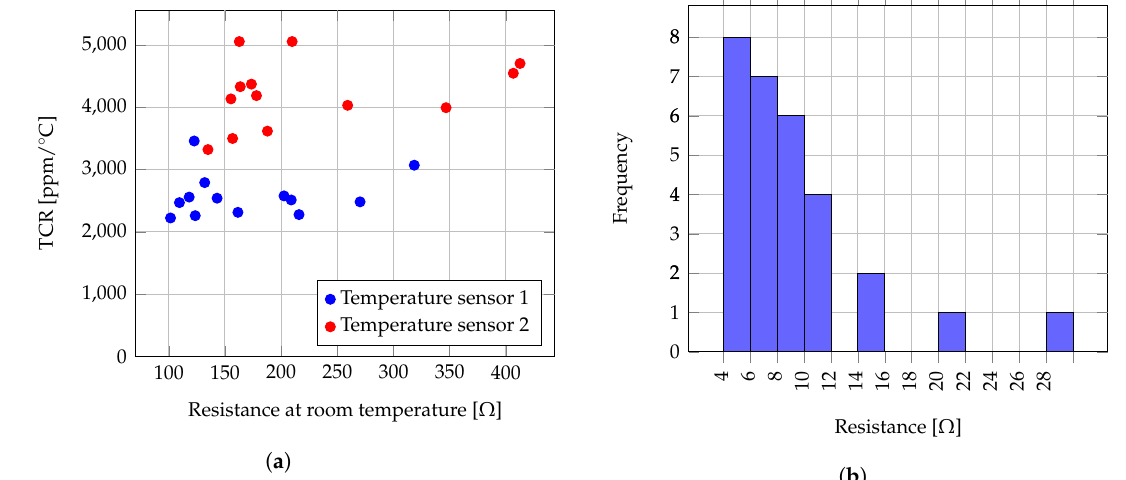
Figure 8. ( a ) Temperature coefficients of resistance (TCR) for samples of temperature sensor 1 (blue) and 2 (red). TCR calculated from room temperature to 95 ◦ C. ( b ) Histogram of resistances from 29 samples of silver ink printed heaters.